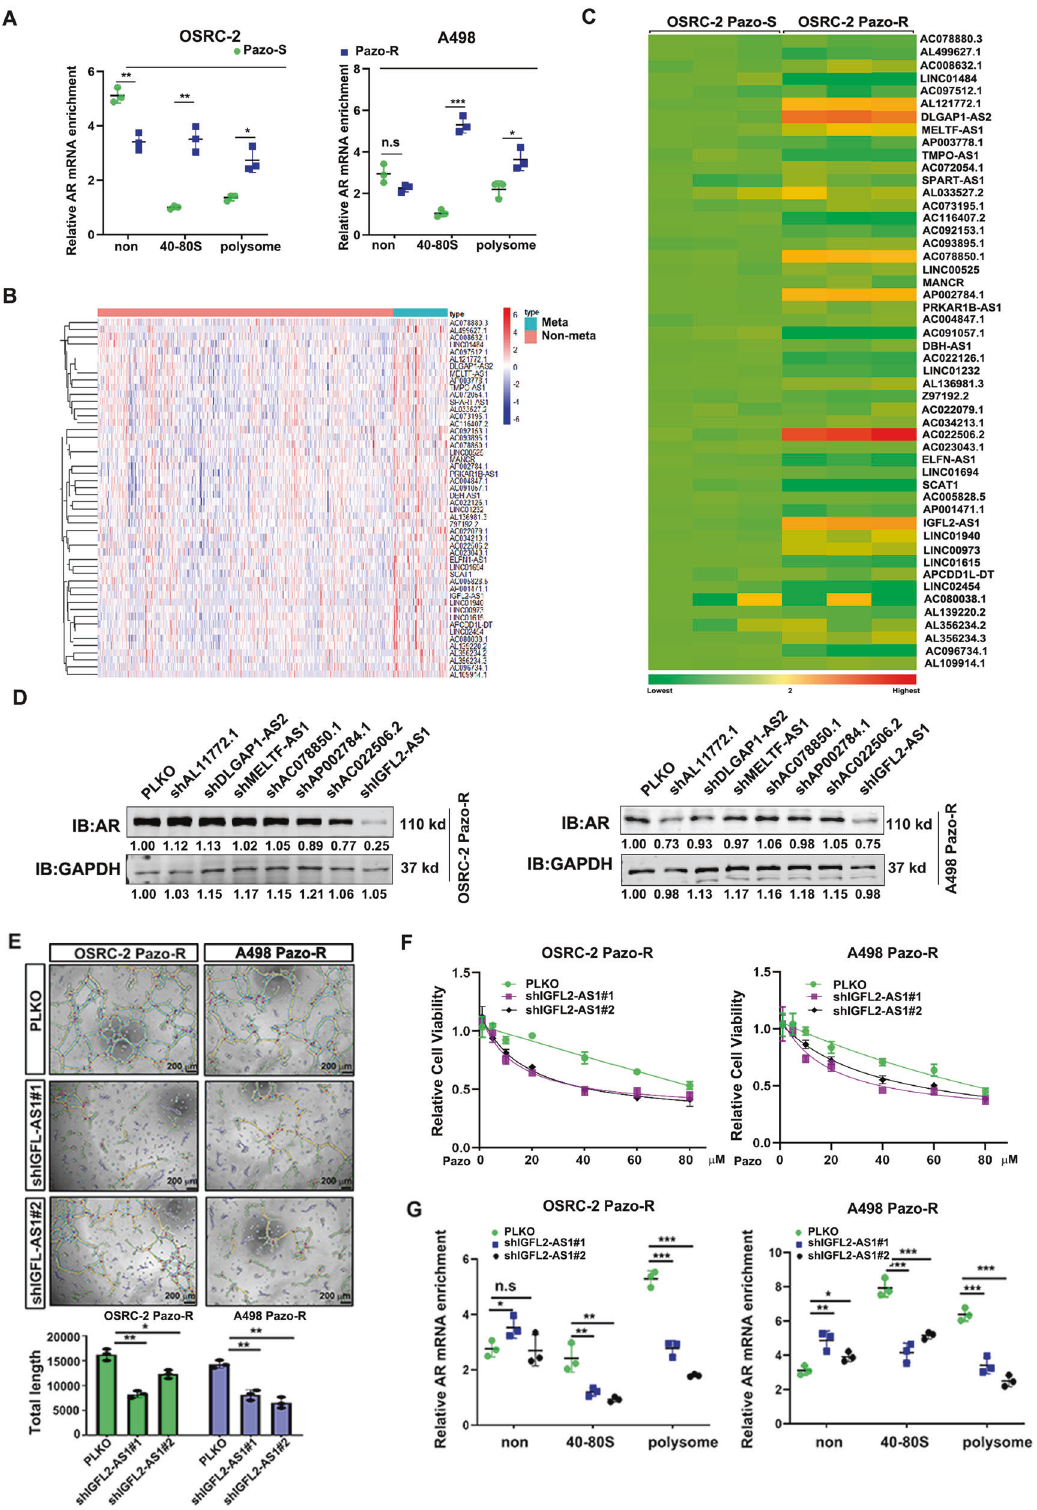
Fig. 2 Determination of IGFL2-AS1 as the upstream regulator of AR in pazopanib resistant ccRCC cells. A Enrichment of AR mRNA with ribosomes in A498 and OSRC-2 before and after pazopanib resistance by polysome pro fi ling assay and followed qPCR detection. B A heatmap of the top 50 lncRNAs highly expressed in metastatic ccRCC. C QPCR assay to detect the expression levels of top 50 metastatic lncRNAs in OSRC-2 pazopanib sensitive and resistant cells. Gene expression level was normalized to GAPDH mRNA. D AR expression level in OSRC-2 (left) and A498 (right) pazopanib resistant cells when lncRNA candidates was knocked down by shRNAs. GAPDH was loading control. E Knockdown of IGFL2-AS1 suppressed the VM development of OSRC-2 and A498 pazopanib resistant cells. Left, representative images. Right, statistical analyses. Scale bar: 200 μ m. F Knockdown of IGFL2-AS1 restored sensitivity of OSRC-2 and A498 pazopanib resistant cells. G Knockdown of IGFL2-AS1 reduced the enrichment of AR mRNA with ribosomes. * P < 0.05; ** P < 0.01; *** P < 0.001, n.s. no signi fi cance. Cell Death Discovery (2023)